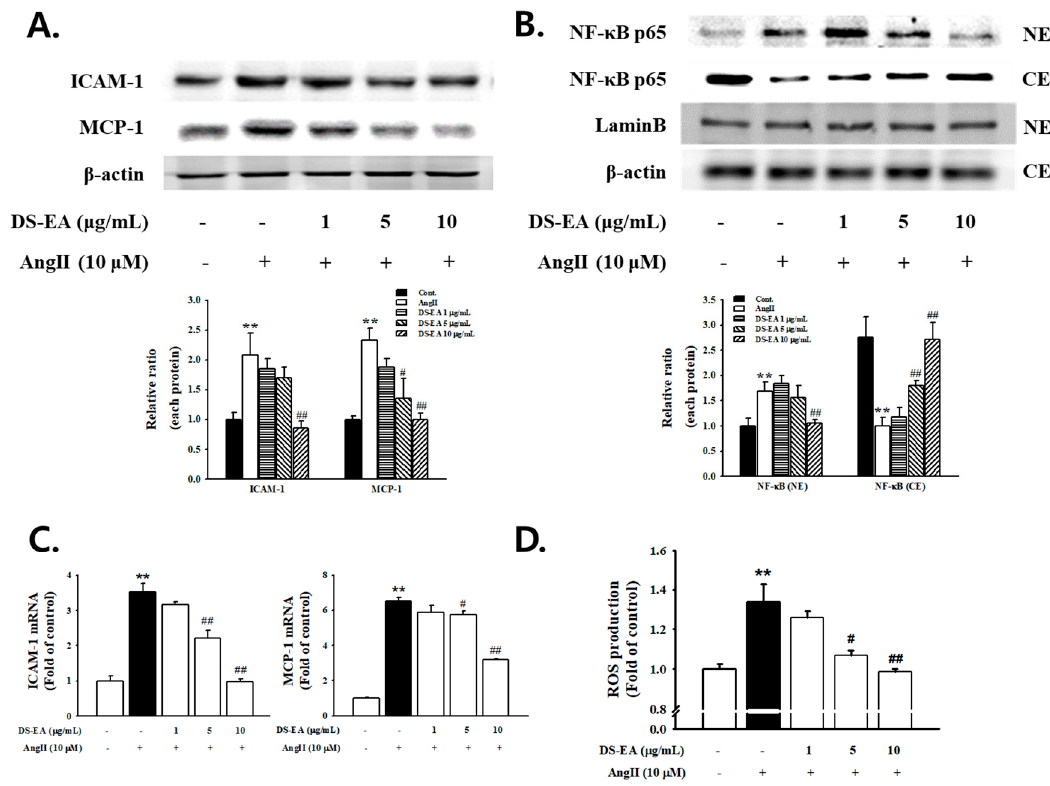
Figure 9. Effect of DS-EA on renal inflammation in human renal mesangial cells. Cells were pretreated with DS-EA for 30 min and then stimulated with Ang II (10 µ M) for 48 h. ( A ) Whole protein was used for western blot analysis with a primary antibody against ICAM-1 (85-110 kDa) and MCP-1 (12 kDa). In addition, β -actin was used as an internal control. ( B ) RT-PCR showed mRNA levels of ICAM-1 and MCP-1. The effect of DS-EA on Ang II-induced NF- κ B translocation ( C ) and reactive oxygen species (ROS) production ( D ) in mesangial cells. For western blot analysis with a primary antibody against NF- κ B p65, nuclear fractions were obtained. Lamin B (67 kDa) was used as an internal control. Each value represents the mean ± S.E. of five independent experiments. ** p < 0.01 vs. control; # p < 0.05, ## p < 0.01 vs. Ang II alone.